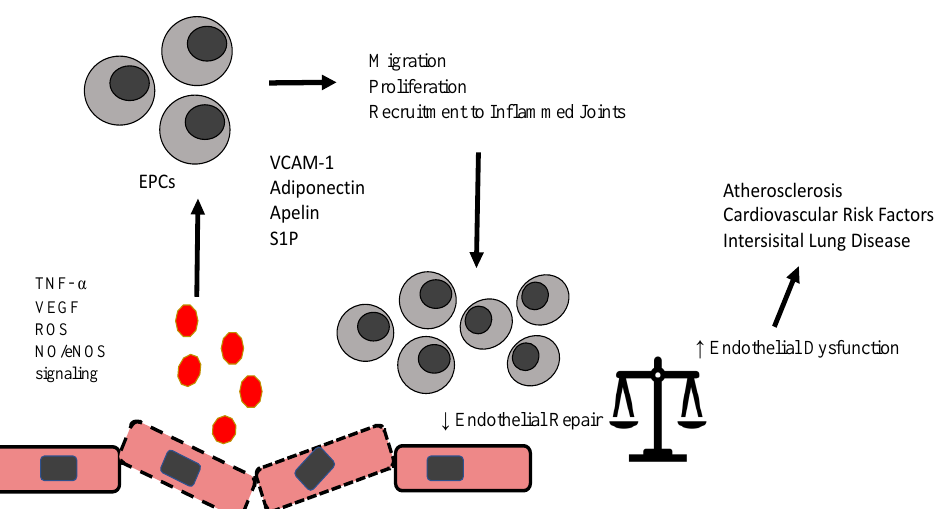
Figure 1. Schematic diagram highlighting modification of EPCs in RA.